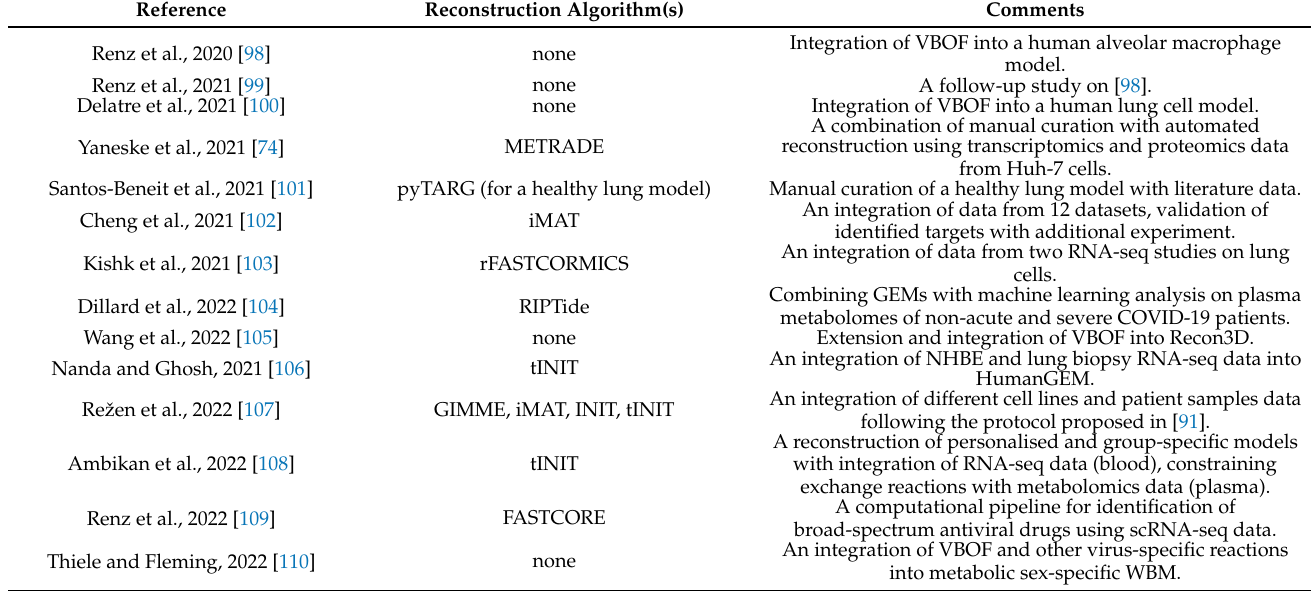
Table 4. An overview of applications of genome-scale metabolic modelling and analysis of